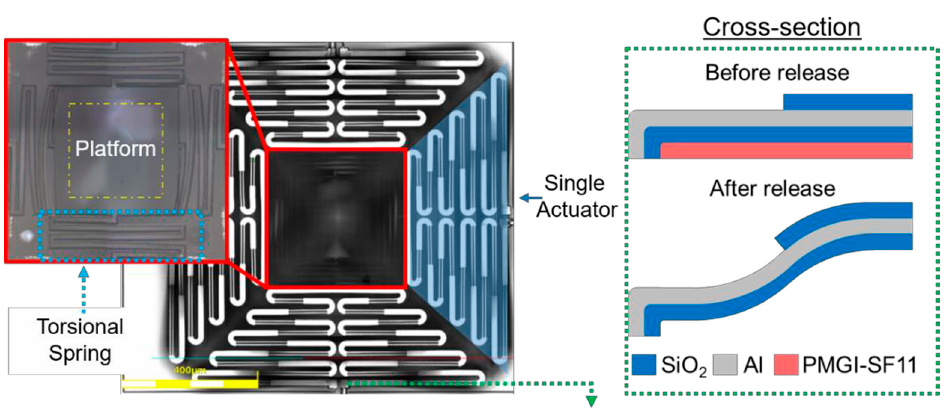
Figure 1. Laser image of the top view of the actuation systems with an inset of an optical image of the SiO 2 platform taken with the Olympus LEXT OLS4100 3D microscope. The inset shows the four torsional spring interconnects which connect the actuators to the platform and the yellow dash box represents the location where the mirror structure would be bonded. A cross-sectional view of the first beam of one actuator (along green line), before and after release, where the second oxide layer changes the bending moment of the beam to force the beam tip downward to increase the overall initial elevation of the actuation/platform